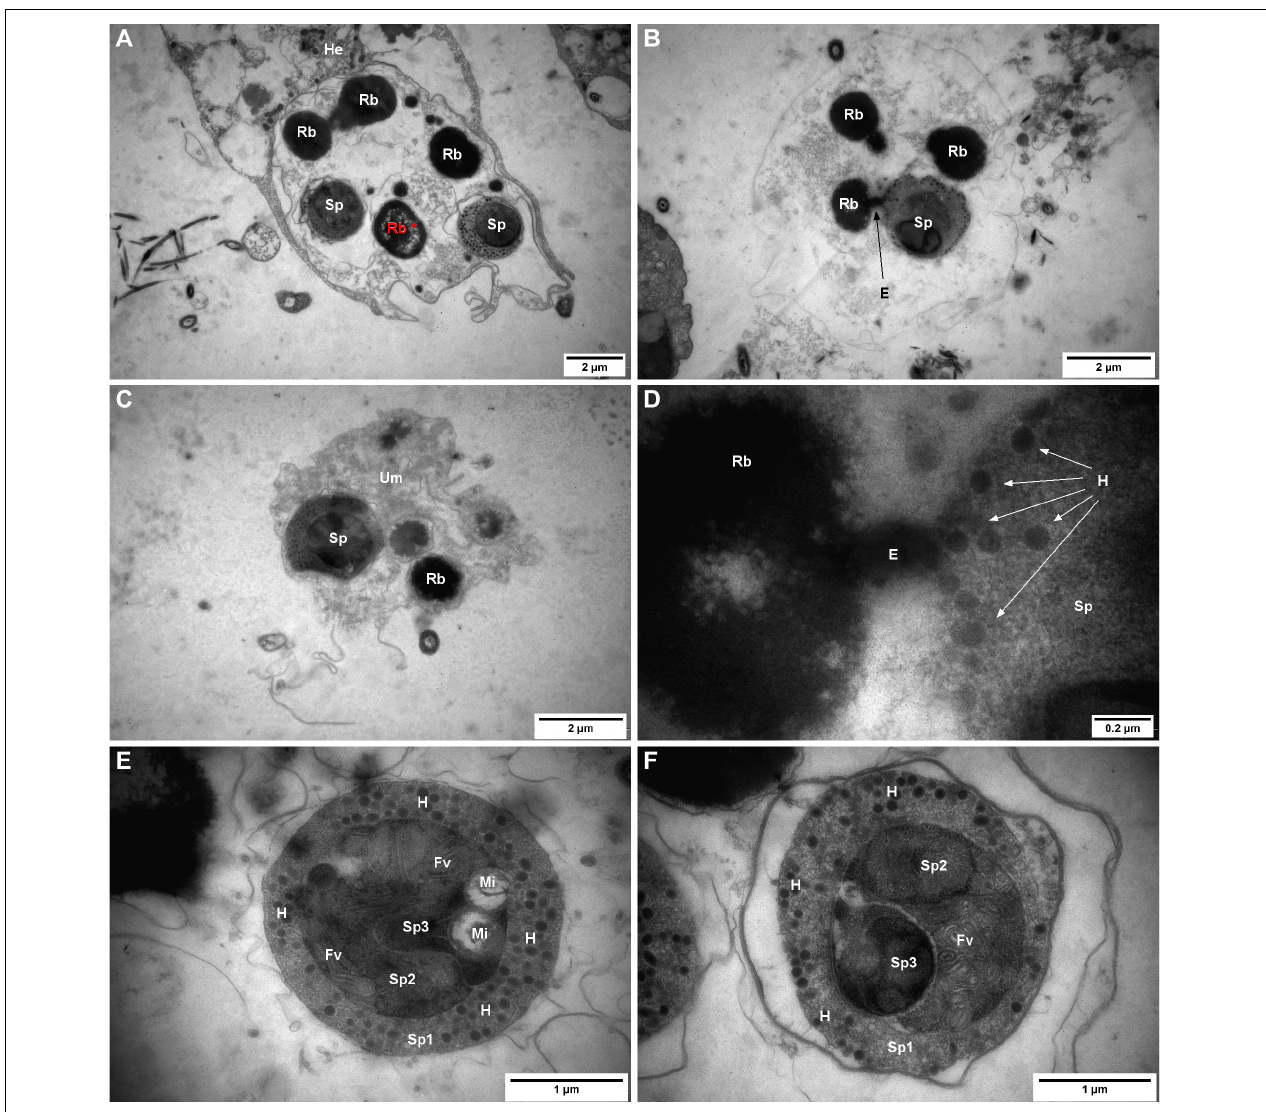
FIGURE 5 | Marteilia refringens cells observed by transmission electron microscopy (TEM) in flat oyster faeces. (A) “Type-1 like cell” containing two matures spores (Sp) and four refringent bodies (Rb) whose show several empty zones (Rb*, red) and surrounded by flat oyster haemocyte (He). (B) “Type-2 like cell” containing one mature spore (Sp) and three refringent bodies (Rb) and showing an excrescence (E) between one refringent body and the mature spore. (C) “Type-3 like cell” containing one mature spore (Sp) and one visible refringent body (Rb) and surrounded by an undetermined matrix (Um). (D) Excrescence between refringent body (Rb) and mature spore (Sp) visible in panel (B) and showing a possible synthesis of haplosporosomes (H). (E) Mature spore containing haplosporosomes (H), mitochondria (Mi), flattened vesicles (Fv), and showing three sporoplasms levels: outermost (Sp1), intermediate (Sp2), and innermost (Sp3). (F) Mature spore containing haplosporosomes (H), flattened vesicles (Fv), and showing three sporoplasms levels: outermost (Sp1), intermediate (Sp2), and innermost